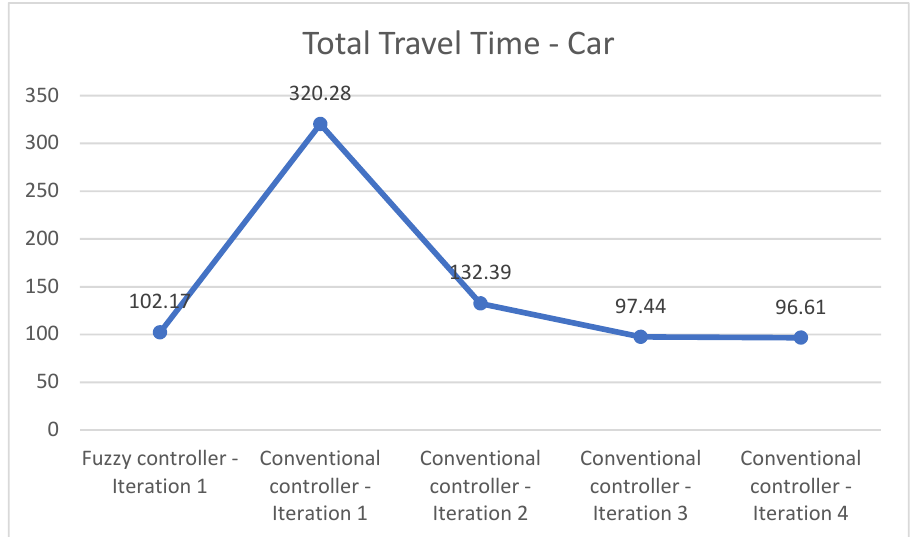
Figure 11. Total travel time for fuzzy and conventional controller for each iteration.